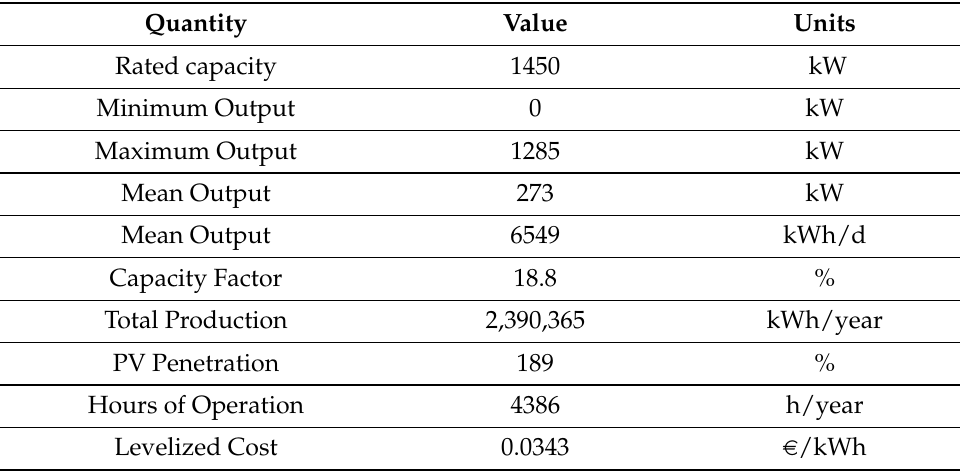
Figure 18. PV power output Case 1 and Case 2 Scenario 3. Table 24. PV Scheme Simulation Results Case 1 and Case 2, Scenario 3.